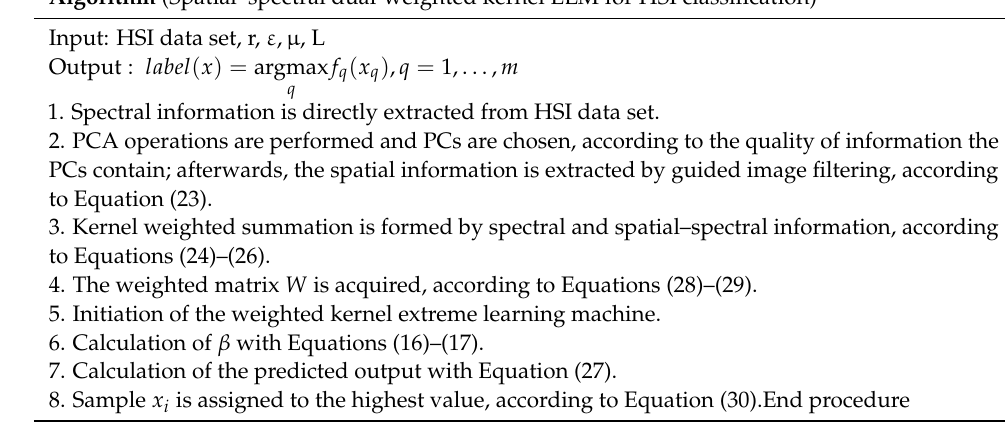
Algorithm (Spatial–spectral dual-weighted kernel ELM for HSI